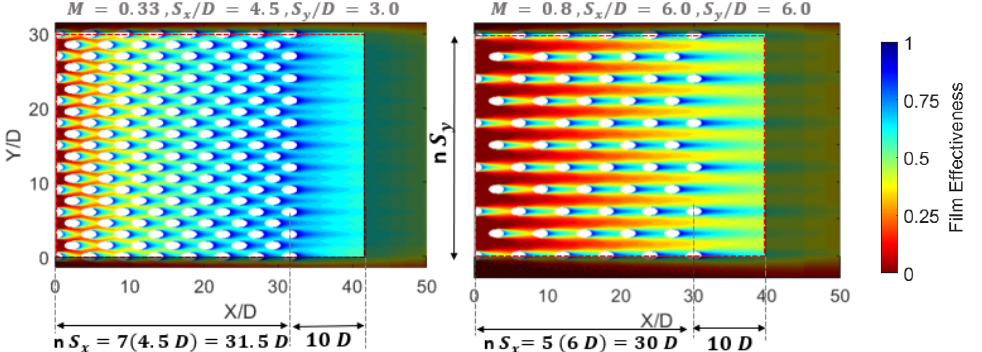
Figure 5. Comparison area for the mean film effectiveness with varying S x / D and S y / D , with a con- stant coolant mass of ˙ m c = 2.56 kg/s/m 2 . Hot streaks are minimised as the spanwise spacing